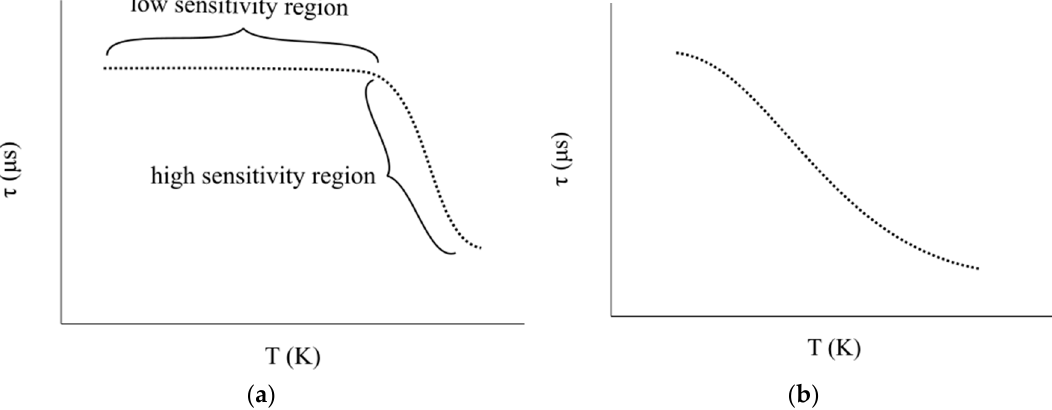
Figure 16. For some systems, the luminescence lifetime τ decreases with increasing temperature. For sensitive higher temperature measurements, it is best to use a chromophore ( a ) for which | d τ / dT | is large (e.g., Ln 3+ doped materials such as YAG:Dy 3+ (see Figure 8 Ref. [19]). For sensitive lower temperature measurements, it is best to use a chromophore ( b ) for which | d τ / dT | is large at lower temperatures (e.g., ruby, Al 2 O 3 :Cr 3+ )